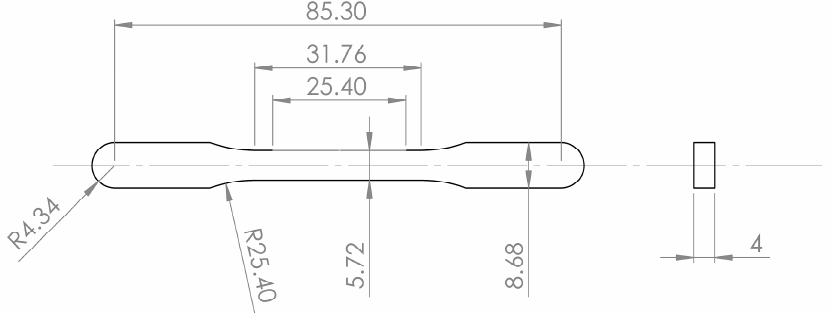
Figure 2. Dog-bone specimen geometry according to the ASTM E8 / E8M-04 Figure 2. Dog ‐ bone specimen geometry according to the ASTM E8/E8M ‐ 04 standard.